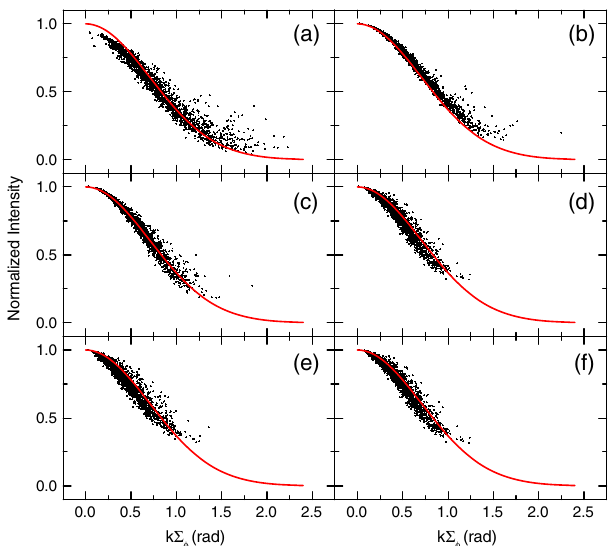
FIG. 6. I r =I 0 (symbol) numerically calculated as a function of k Σ ϕ defined by Eq. (42) for each undulator model, in comparison with the analytical formula ρ (line) defined by (41).